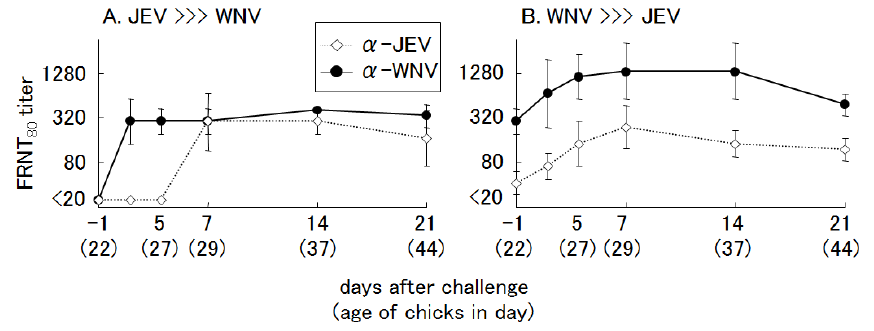
Figure 11. Neutralizing antibody responses in chicks after a secondary challenge with heterologous viruses. Two-day-old chicks ( n = 4) were inoculated with 100 plaque forming units (PFU) of primary viruses: ( A ) Japanese encephalitis (JE) virus, ( B ) West Nile (WN) virus. After 3 weeks, the chicks (23 days old) were inoculated again with 1,000 PFU of heterologous virus: ( A ) WN virus, ( B ) JE virus. Anti-JE virus ( ◇ ) and -WN virus ( ● ) neutralizing antibody titers were measured by FRNT and are expressed as the mean ± 80